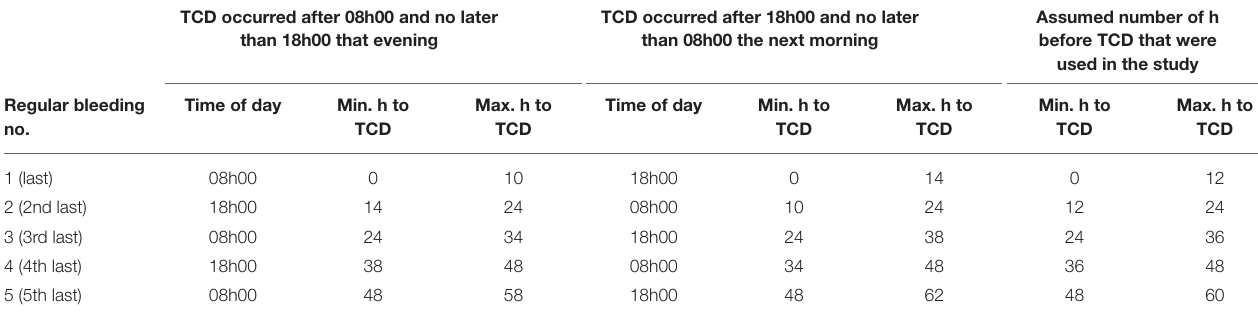
TABLE 1 | Intervals between regular bleeding times and the time of cervical dilatation (TCD) in h. TCD occurred after 08h00 and no later than 18h00 that evening